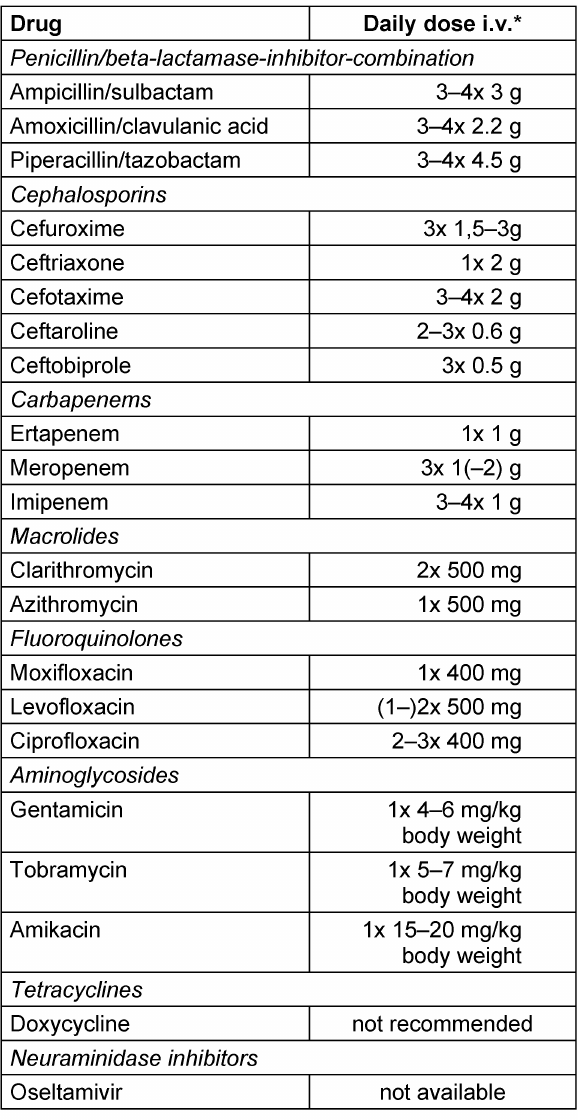
Table 7: Dosage recommendations for the